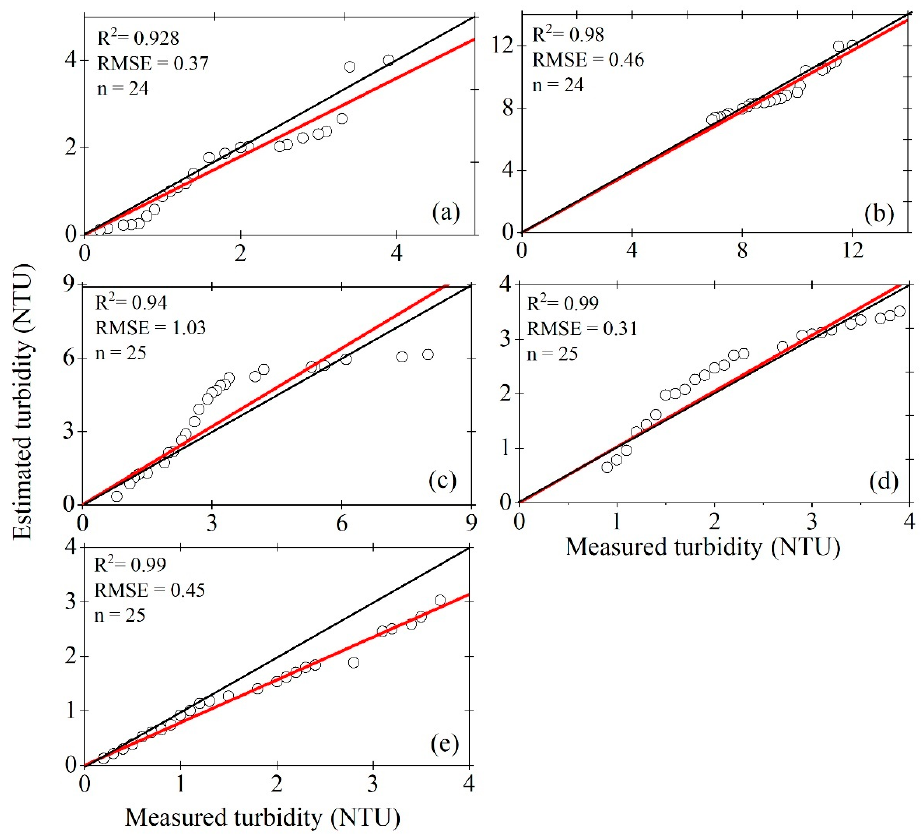
Figure 4. Estimated and measured turbidity for each lake, ( a ) Calafquén, ( b ) Neltume ( c ) Panguipulli, ( d ) Riñihue ( e ) Puyehue lake. The red and the solid black line represent the regression line and the 1:1 line, respectively.